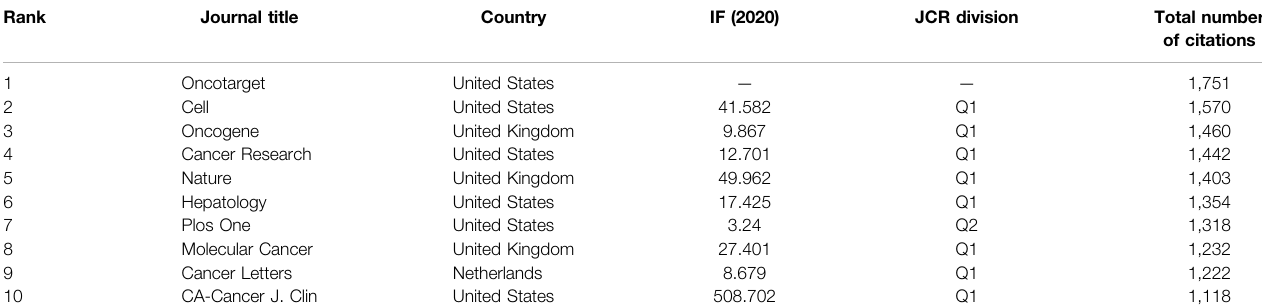
TABLE 2 | The top 10 co-cited journals involved in the roles of lncRNAs in HCC development research.